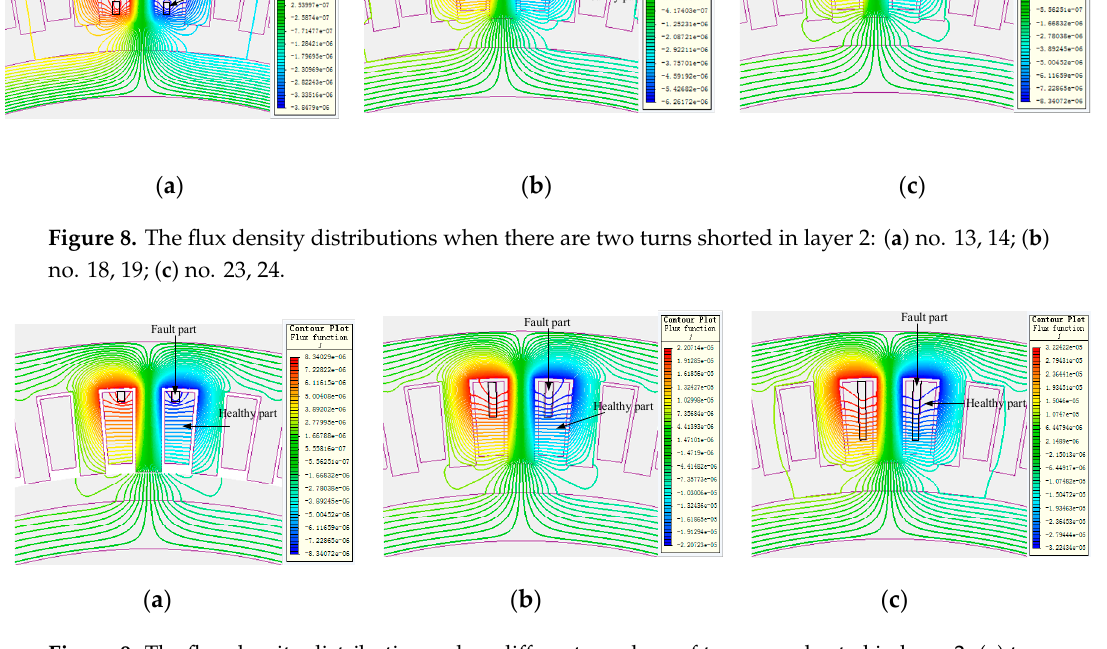
Figure 10. The inductances of the faulty coil when there are two turns shorted in layer 2: ( a ) self-inductance in faulty part; ( b ) self-inductance in healthy part; ( c ) mutual inductance.